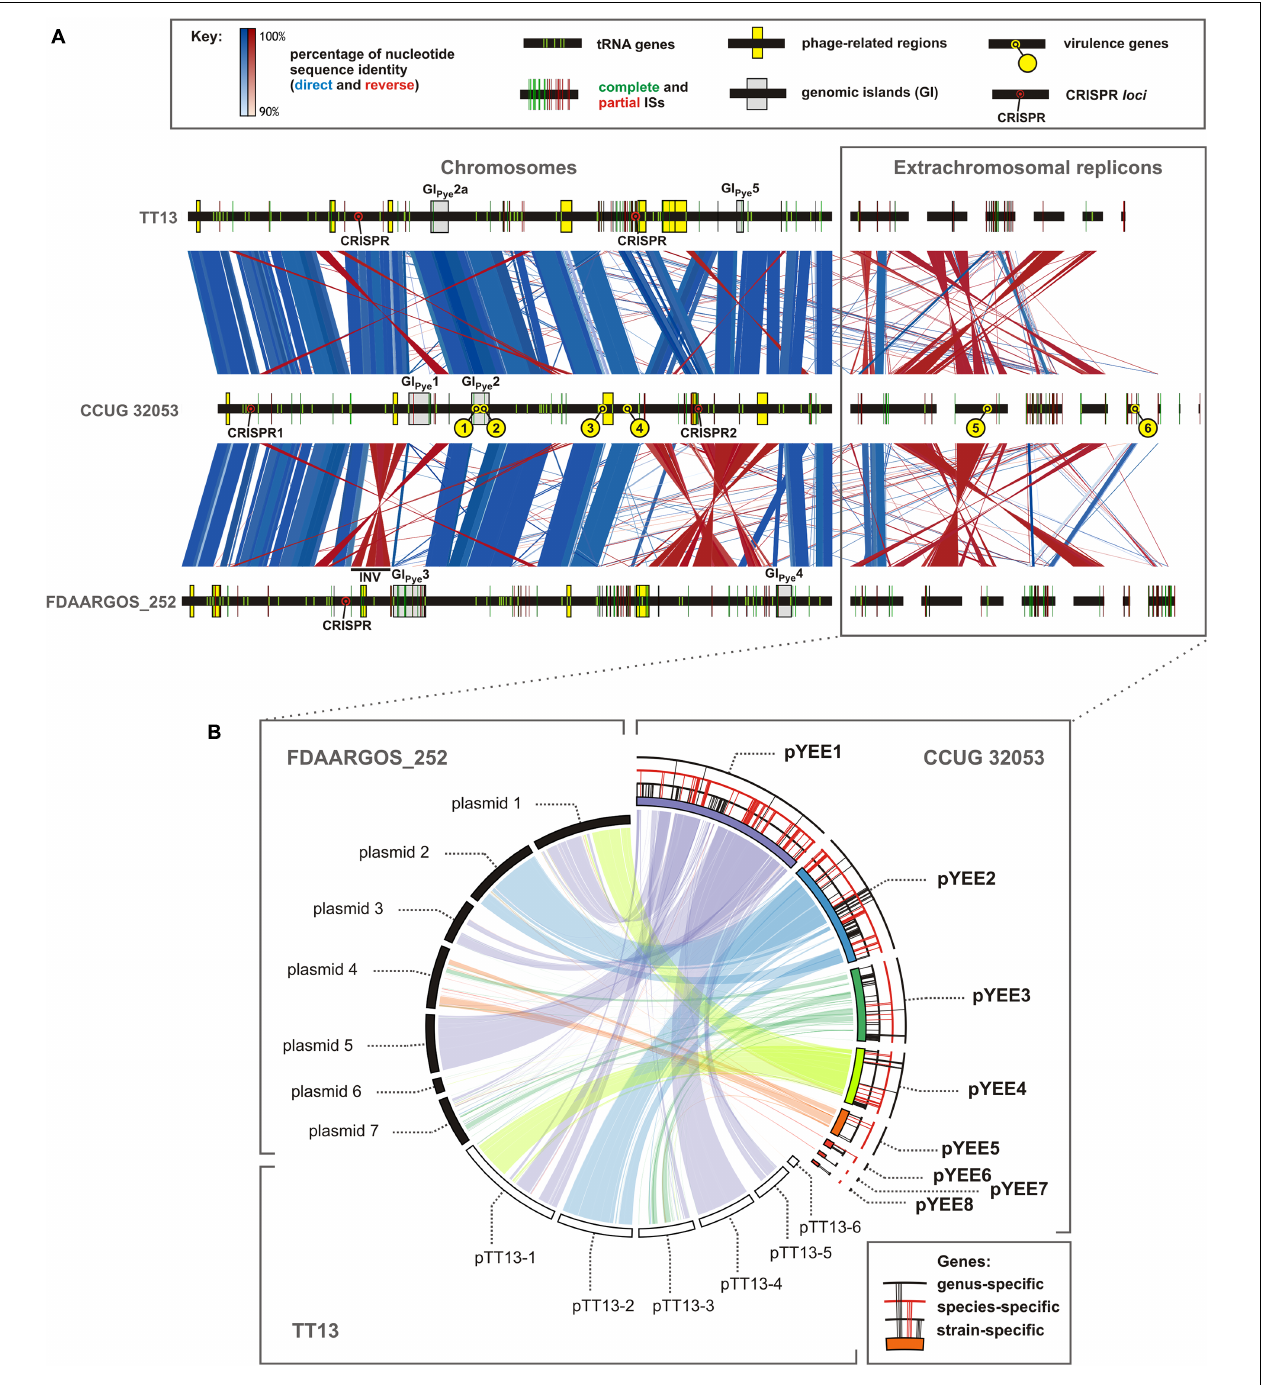
FIGURE 1 | Comparative genomic analysis of three strains of Paracoccus yeei : TT13, CCUG 32053, and FDAARGOS_252. (A) Whole genome synteny analysis, visualized using EasyFig software. The localization of the identified tRNA genes, insertion sequences, phage-related regions, genomic islands, CRISPR loci and the putative CCUG 32053 virulence-related genes is presented as indicated in the key. INV - inverted a 217-kb-long segment of chromosomal DNA (in FDAAGOS_252) flanked by two copies of IS Pye28 . (B) Relationship between ECRs of CCUG 32053 and ECRs of other strains of P. yeei , visualized using Circoletto software. The localization of the genus-, species- and strain-specific genes within the replicons of the CCUG 32053 strain is presented as indicated in the key. The detailed description of the methodology used to generate the figure is to be found in Supplementary Table S2 .